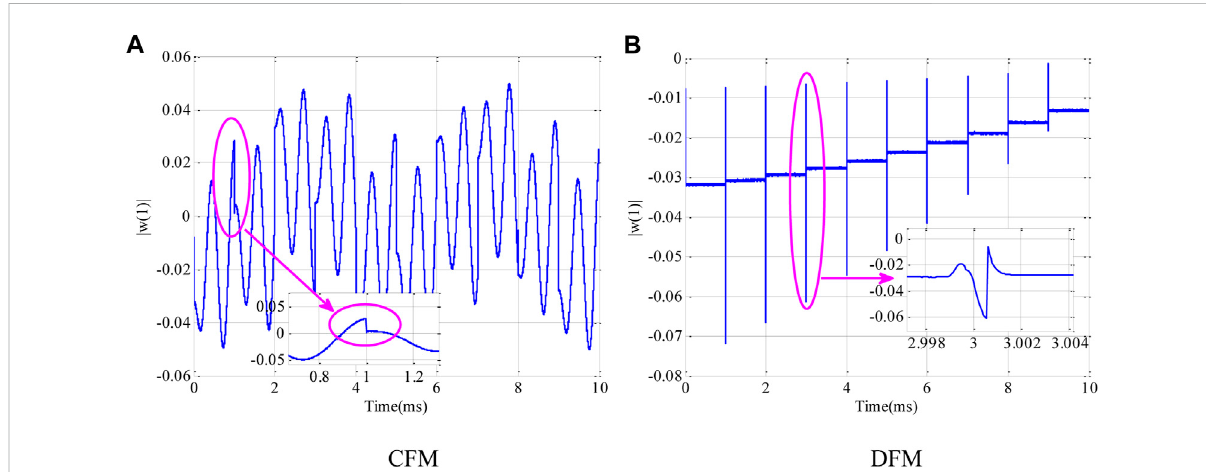
FIGURE 13 Impact of timing reset on adaptive convergence. (A) CFM (B) DFM.